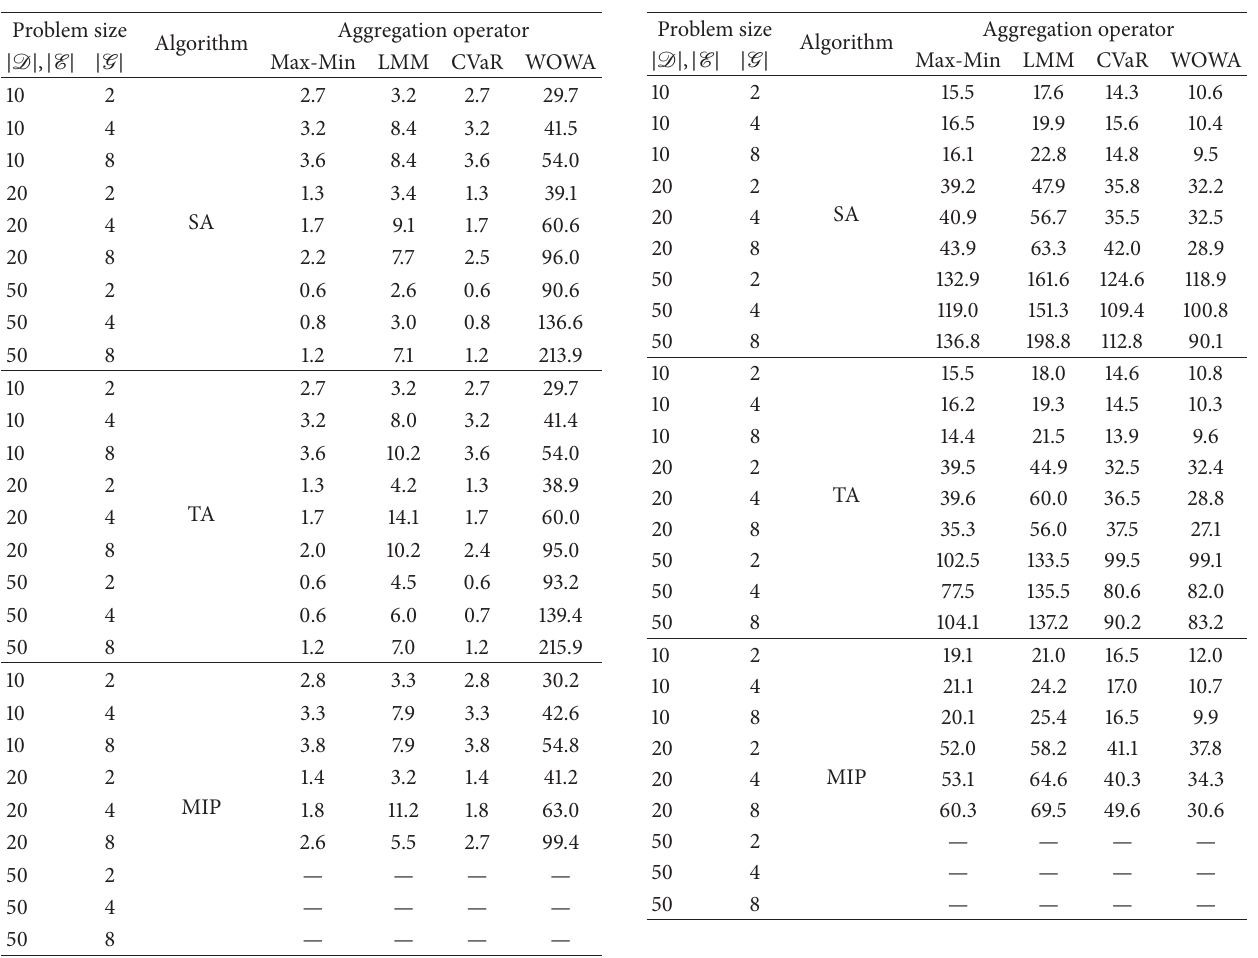
Table 4: Optimal problem values (maximization). Table 5: Number of compatible sets